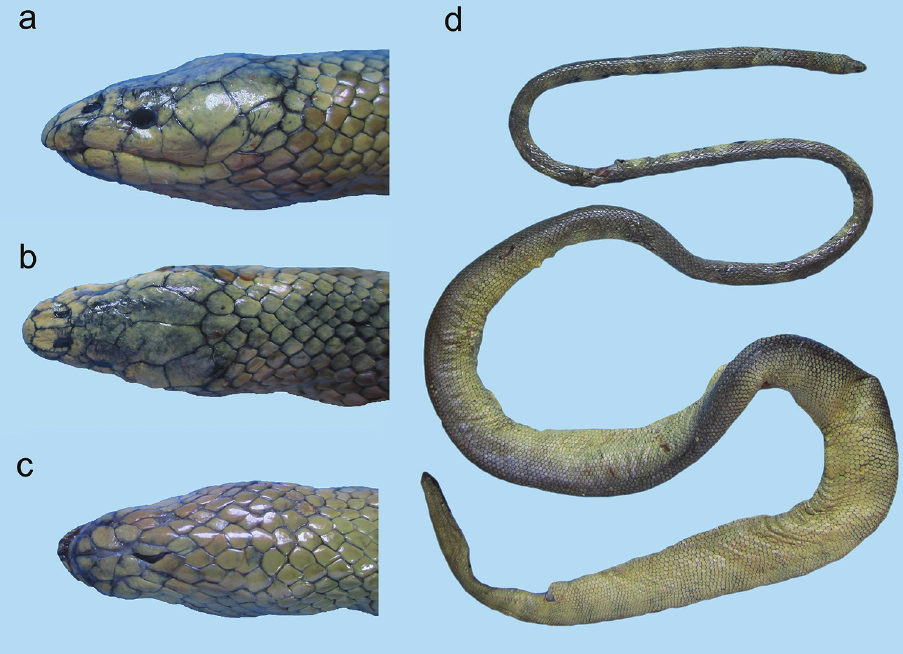
Figure 26. Microcephalophis cantoris : a lateral view b dorsal view, and c ventral view of head d body. Coloration. Head yellowish; neck and body dark olive dorsally, yellowish ventrally; dorsal portion of body uniform in color and not banded; neck with the rings paler dor- sally and black ventrally (Figure 26d); [Dark greenish olive dorsally, yellowish